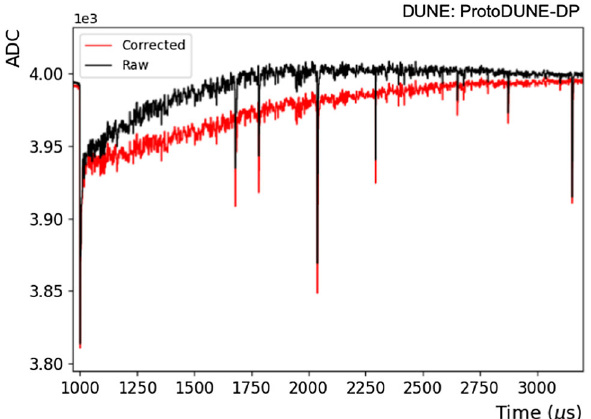
Fig. 24 Example of a scintillation light event in a ProtoDUNE-DP PMT at a gain of 10 7 in LAr with drift, amplification and extraction fields (S1 and S2 signal). The acquired waveform is shown in black and the resulting waveform after the overshooting correction in red